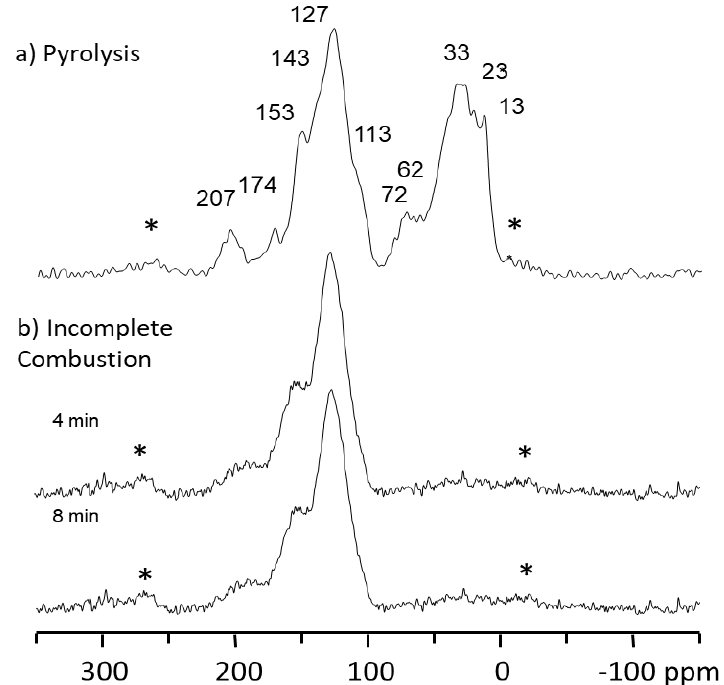
Figure 3. Solid-state 1D NMR spectra of charred cellulose produced after pyrolysis of 350 °C ( a ) and incomplete combustion in the presence of oxygen for 4 and 8 min ( b ) [29]. The asterisks indicate spinning side bands, which result from the modulation of the magnetic field at the spinning frequency and contain intensity of the parent signal (in this case the aryl C).